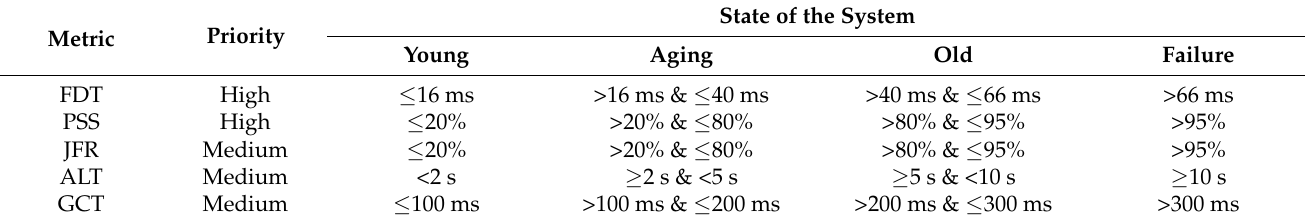
Table 1. Metrics and their thresholds for determining the aging level of the system.